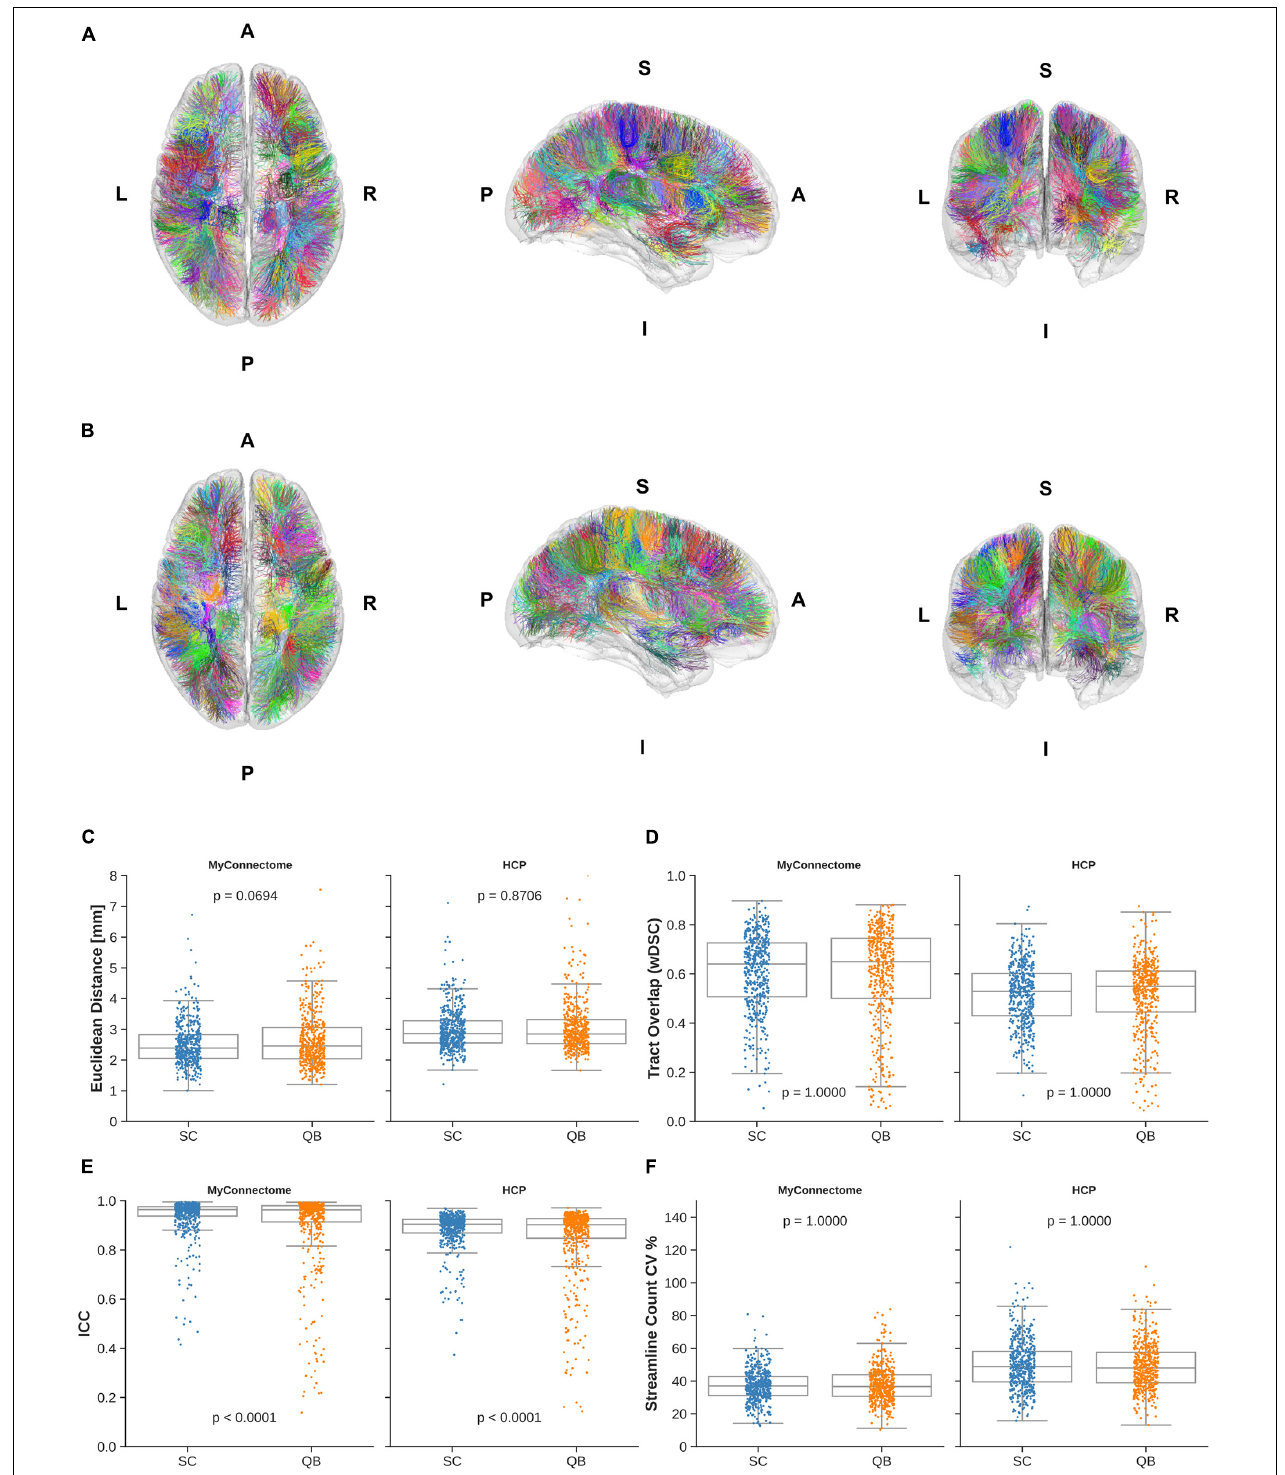
FIGURE 4 | “U”-shaped tracts identified in the HCPUR100 template viewed from axial superior (left), sagittal right (middle), and coronal anterior (right) via (A) spectral clustering and (B) QuickBundle clustering. Colors of identified tracts do not correspond across clustering methods. Individual observations in “U”-shaped tracts for a given metric are overlaid on a box plot for each dataset and clustering method employed by the template. (C) Mean Euclidean distance of tracts relative to the corresponding average tract centroid. (D) Average voxel-wise spatial overlap across corresponding tracts. (E) Along-tract absolute agreement of fractional anisotropy across corresponding tracts. (F) Variability of streamline counts across corresponding